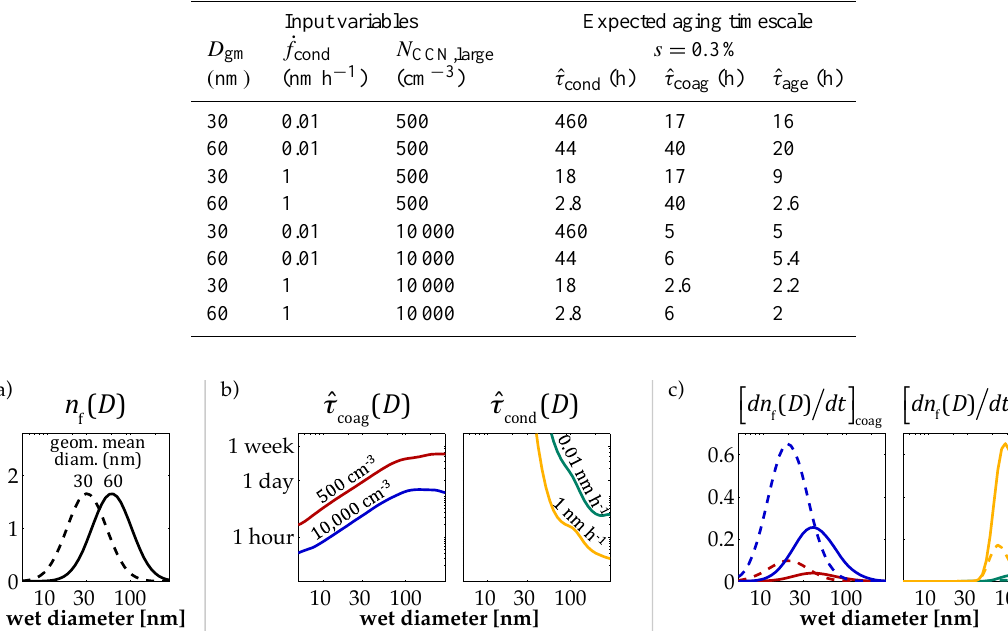
Figure 10. Rate at which particles of specific size transition from fresh to aged (c) depends on size distribution of fresh BC (a) and size- resolved aging timescale (b) . Results are shown at s = 0 . 3%, where the size-resolved aging timescale under different conditions are deter- mined from the regression function in Fig. 9. The line colors in panel (c) correspond to the aging conditions shown in panel (b) , and the line style in panel (c) correspond to the size distributions shown in panel (a)